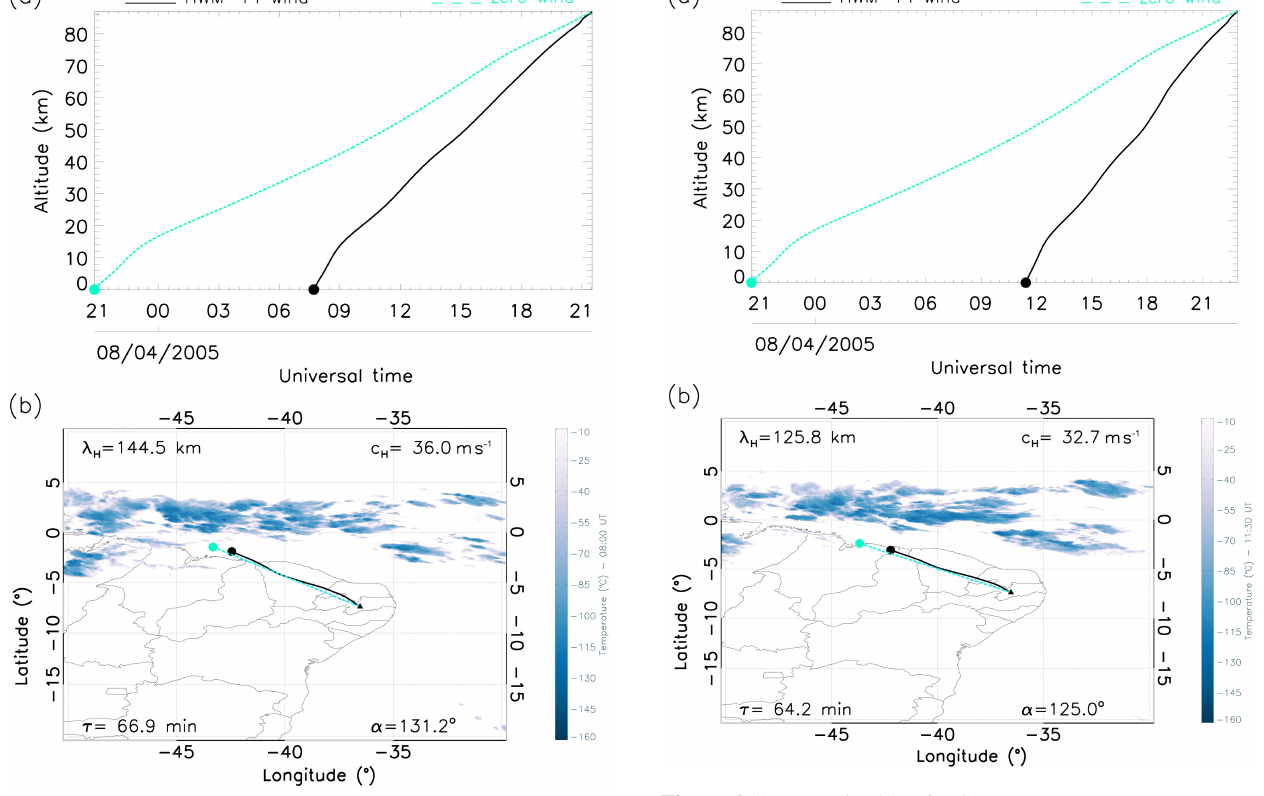
Figure 5. Same as in Fig. 4 but for GW 2 .